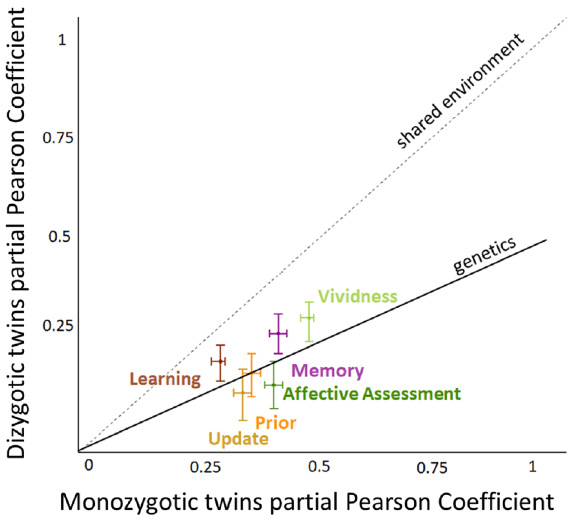
Figure 4. Plotted on the Y axis is the mean partial Pearson coefficient between DZ twins. Plotted on the X axis is the mean partial Pearson coefficient between MZ twins. Each cross represents a phenotype, clearly marked on the graph. The size of the cross’s line represents the the 2.5% and 97.5% estimates of the distribution. If the similarity on a phenotype within a twin pair is explained by shared environment alone than the mean coefficient should be the same for MZ twins and DZ twins. In such cases the cross should fall on the dotted line. If the similarity on a phenotype within a twin pair is also explained by genetics than the mean coefficient should be larger for MZ twins than DZ twins and fall near the dotted line. The closer the cross is to the bold line the greater the impact of heritability on the phenotype. The partial coefficient are calculated while controlling for